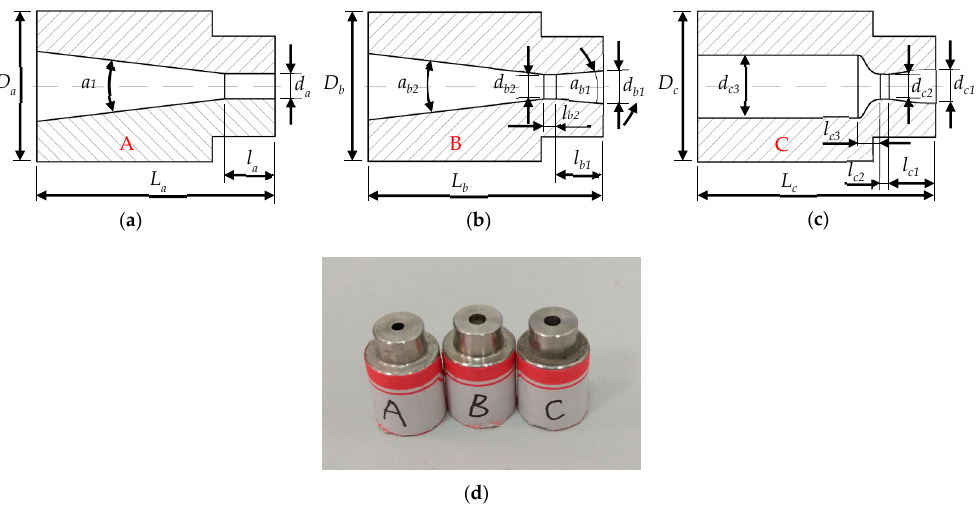
Figure 3. Detailed structural parameters of the nozzles: ( a ) Convergent nozzle; ( b ) Laval-1 nozzle; ( c ) Laval-2 nozzle; ( d ) Pictures of the nozzles.